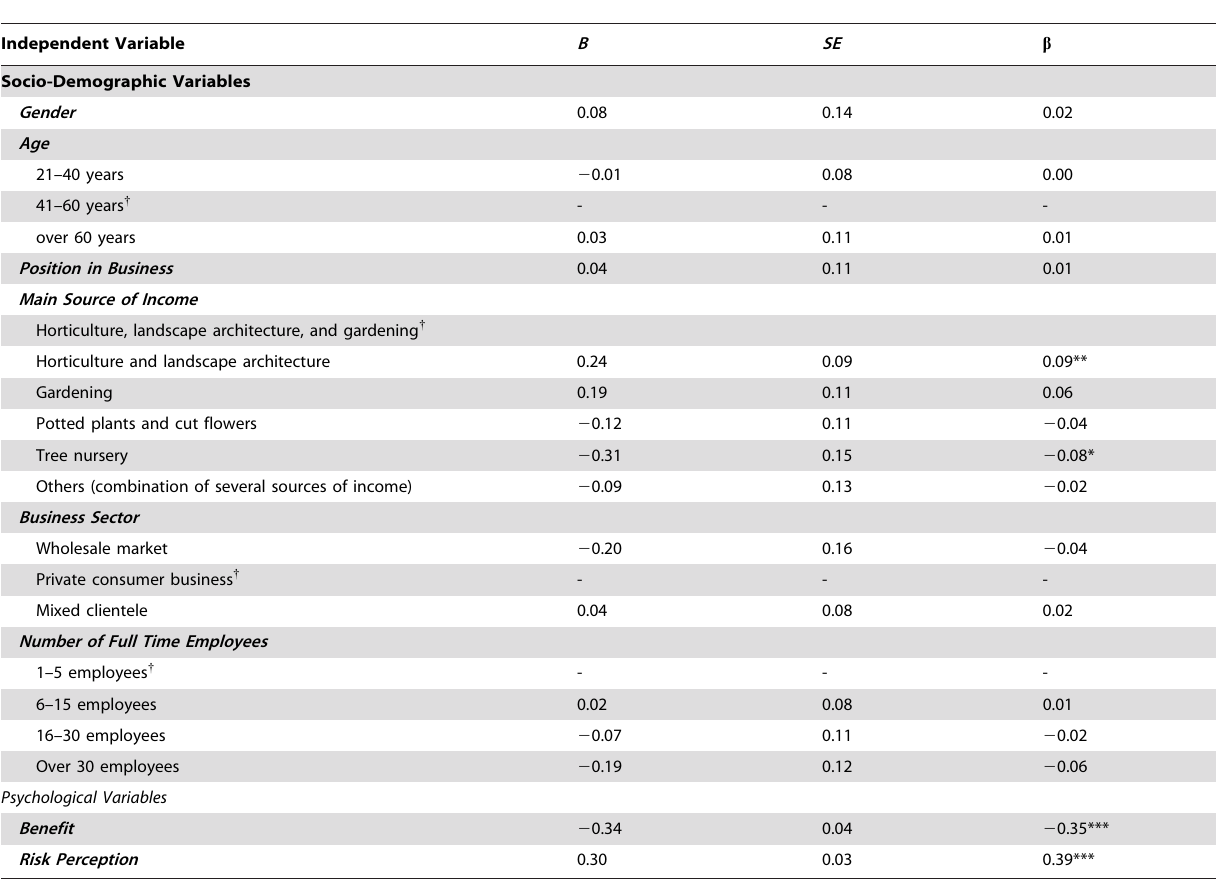
Table 5. Results of multiple regression analysis with Willingness to Engage in Risk Mitigation Behavior as dependent